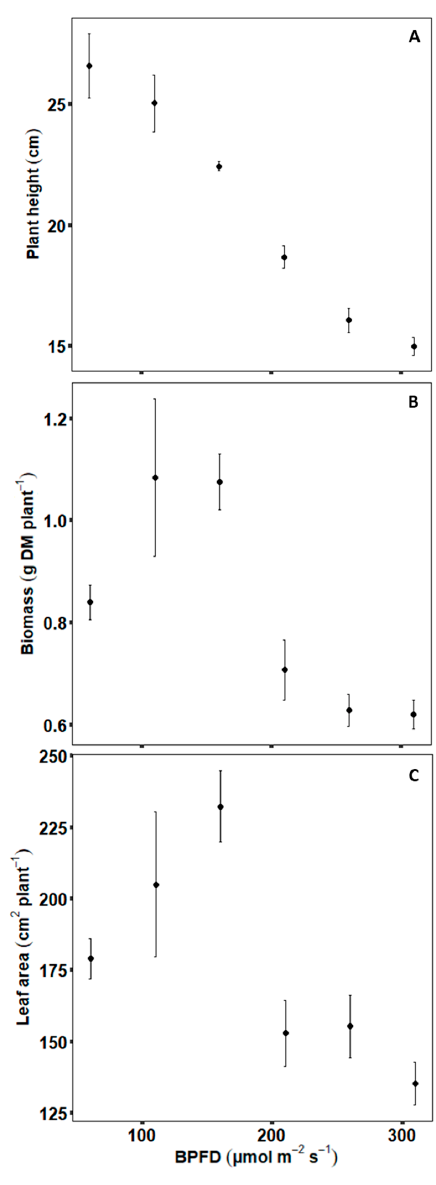
Figure 1. Final plant height ( A ), biomass ( B ) and leaf area ( C ) under di ff erent blue photosynthetic flux densities (BPFD). Error bars indicate standard error of the mean ( n =